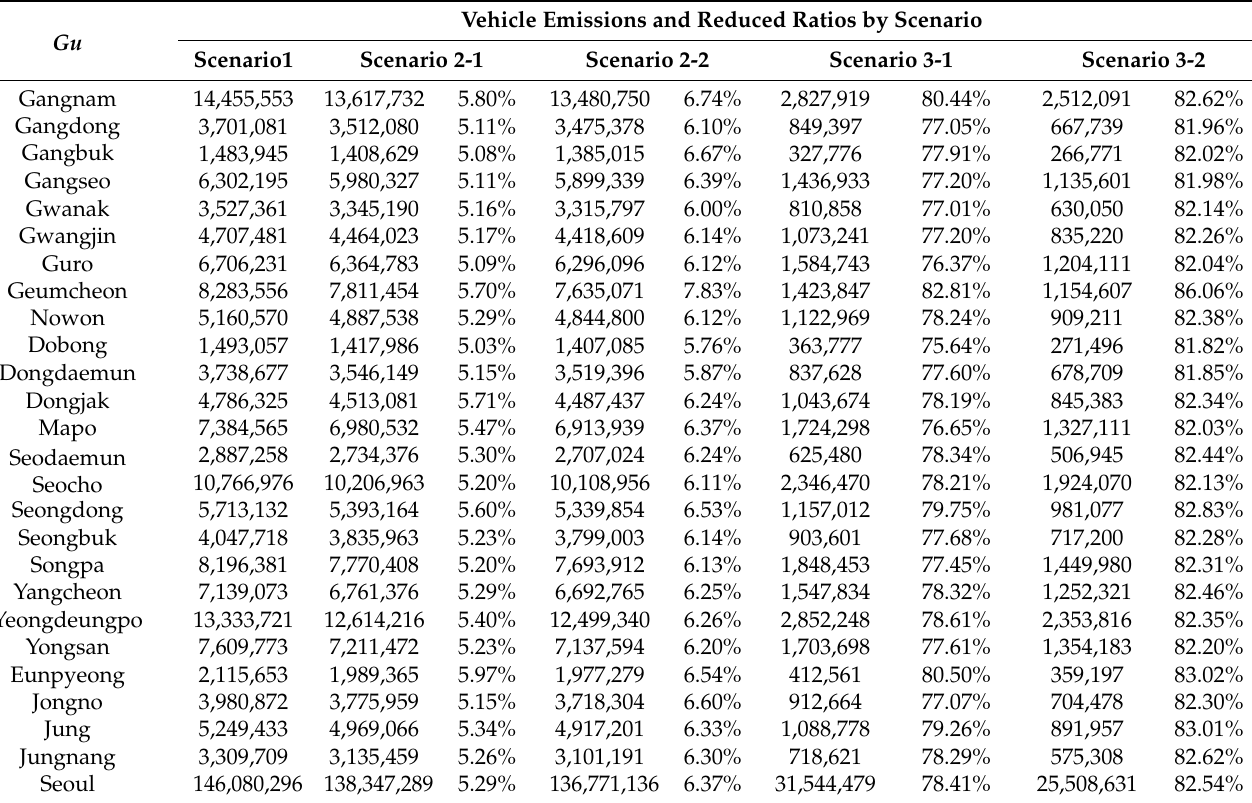
Table 1. Scenario 2 vehicle emissions and reduction efficiency by autonomous district ( Gu